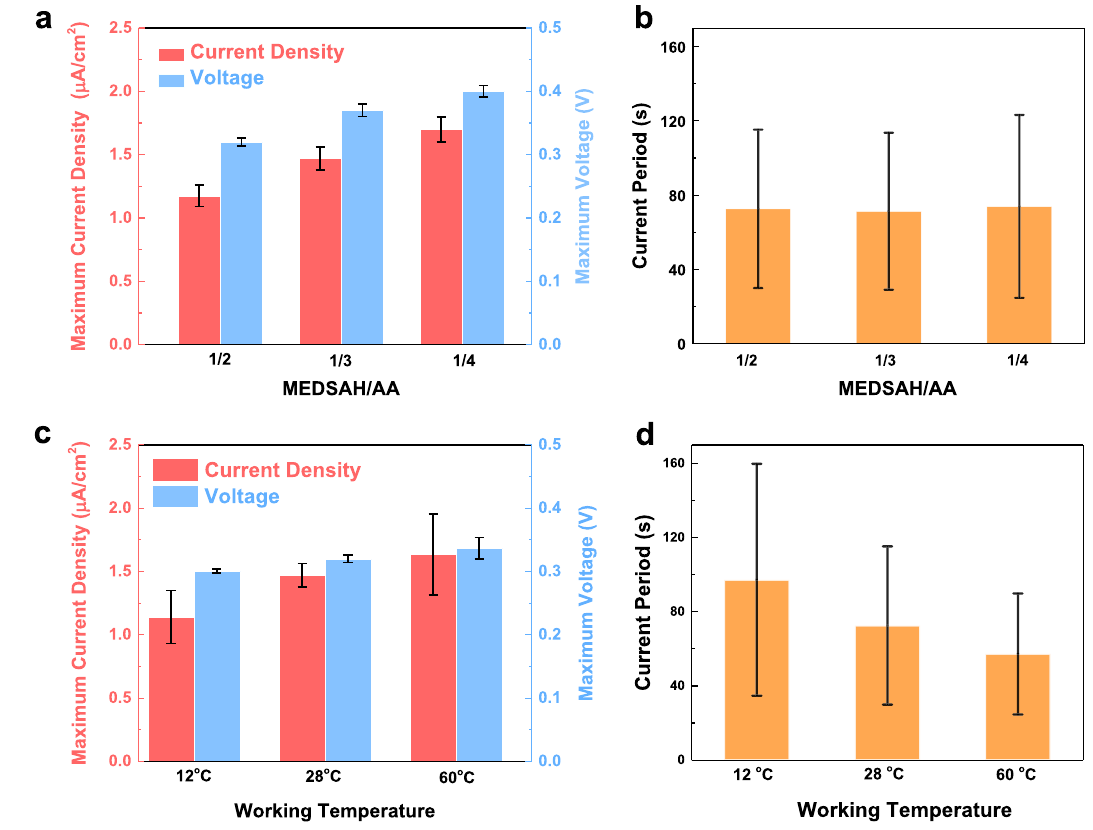
Fig. 4 Electrical output characterizations for moisture-induced energy harvesters with different monomer ratios and under different temperature environments. a Maximum short-circuit current density and open-circuit voltage for energy harvesters with the [2-(methacryloyloxy)ethyl] dimethyl-(3- sulfopropyl) ammonium hydroxide (MEDSAH)/acrylic acid (AA) ratios of 1/2, 1/3, and 1/4 at 28 o C. b Measured average electrical oscillation output periods of energy harvesters with MEDSAH/AA ratios of 1/2, 1/3, and 1/4, under 28 °C. c Maximum short-circuit current density and open-circuit voltage of energy harvesters at operating temperatures of 12, 28, and 60 °C, respectively. d Measured average electrical oscillation output periods of energy harvesters at temperatures of 12, 28, and 60 °C, respectively. The error bars show the range of minimum and maximum